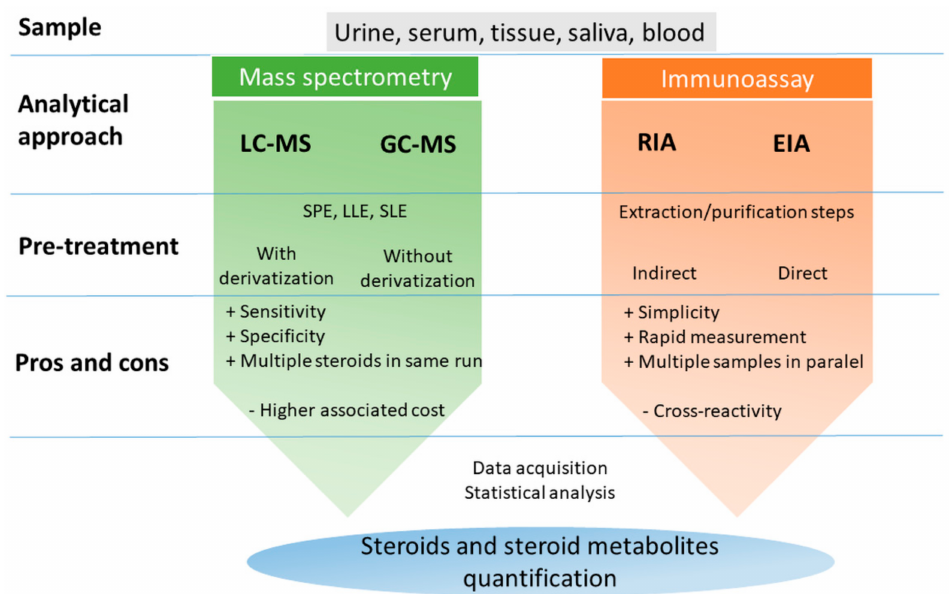
Figure 3. The main techniques for steroids determination in different biological samples. LC-MS—liquid chromatography- mass spectroscopy; GC-MS—gas chromatography-mass spectrometry; RIA—radioimmunoassay; EIA—enzyme immunoas-